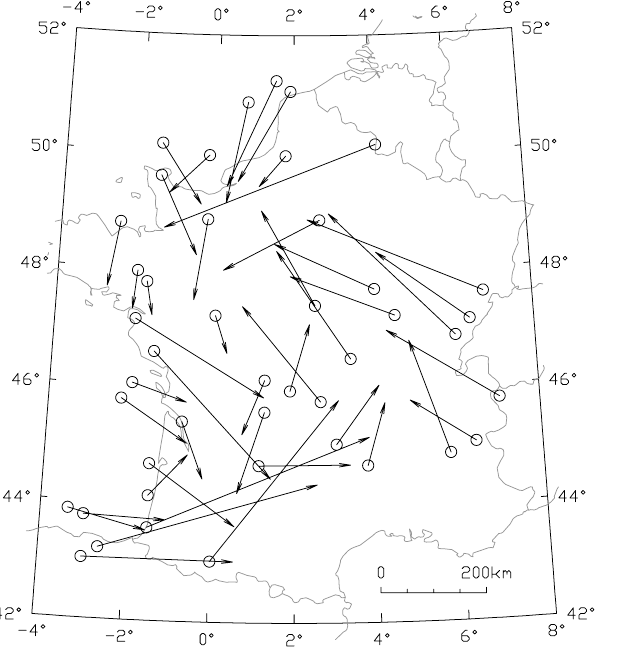
Figure 3. Gallia Aquitania and Gallia Lugdunensis : residual plot after an adjustment of scale and shift ( point : (¯ λ, ¯ φ ), arrowhead : ( λ,φ